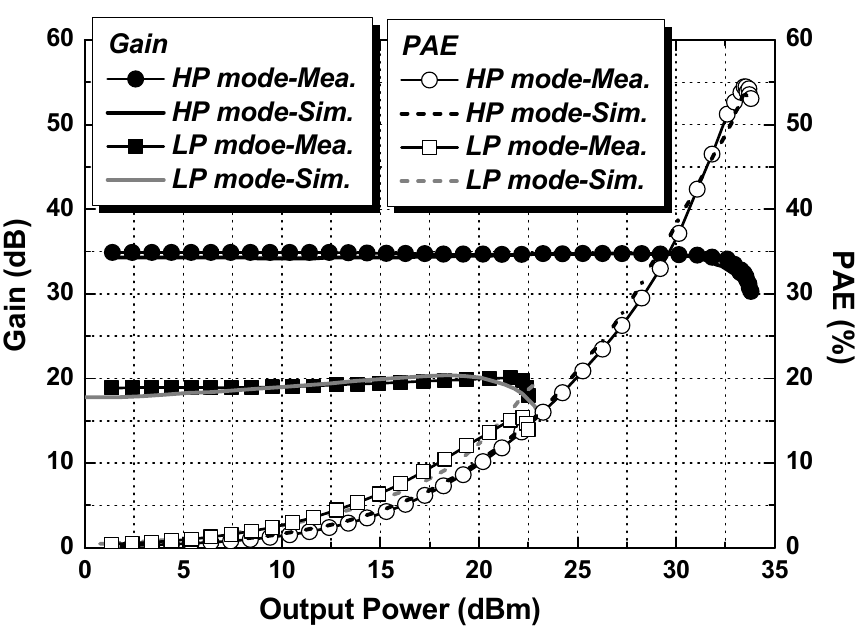
Figure 13. Measured 0.91 GHz continuous wave performance. Additionally, the PA was also tested with a two-tone signal centered at 0.91 GHz with a tone spacing of 10 MHz. Figure 14 shows the measured IMD3 results versus the output power. The PA yields output powers of 27.5 dBm and 13.0 dBm in the HP and LP modes, respectively, while attaining IMD3 results of less than − 35 dBc. As shown in Figure 9, owing to the mechanism of the IMD3 cancellation, the IMD3 results of less than − 35 dBc are obtained up to an output power of 27.5 dBm in the HP